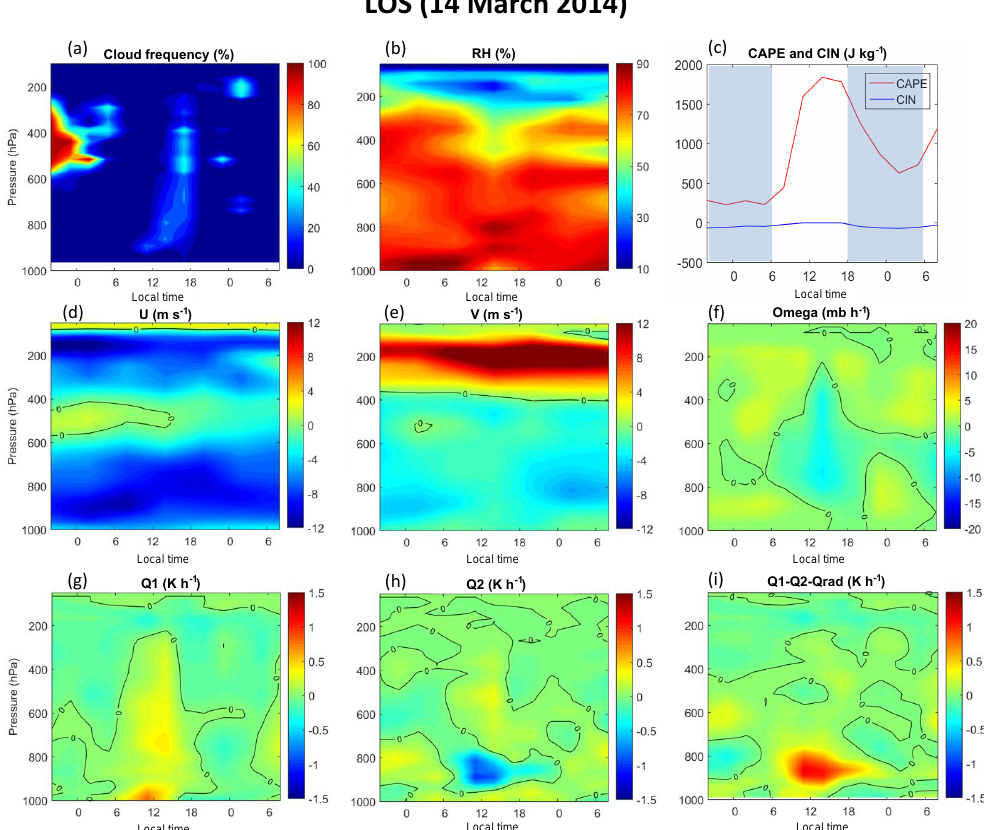
Figure 10. The time series of (a) cloud frequency, (b) relative humidity, (c) surface CAPE and CIN, (d) u wind, (e) v wind, (f) vertical velocity, (g) Q 1 , (h) Q 2 and (i) Q 1 − Q 2 − Q rad for the LOS case. The black lines are zero-lines. The shaded and white areas in (b) indicate nighttime and